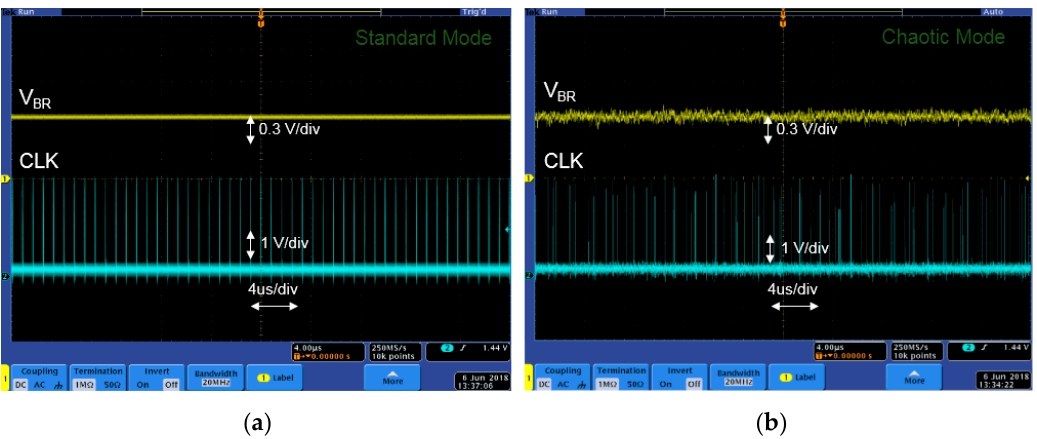
Figure 16. Measurement result of the chaotic ramp generator: ( a ) Standard mode: triangular ramp generator with fixed switching frequency of 1.2 MHz (1.214 MHz); ( b ) Chaotic mode: ramp generator with chaotic switching frequency at F SW +/ − 20%. (Channel 1: V BR ; Channel 2: clock impulse signal. The width of measured impulse: ~15 ns; (X: 4 us/div, Y: 0.3 V/div)).